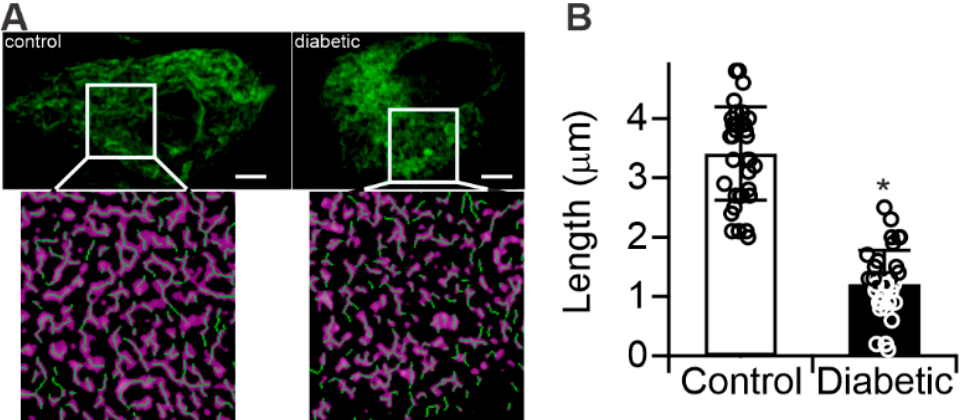
Figure 3. Structural analysis of human RPE mitochondria. ( A ) Mitochondrial morphology determined by MitoTracker Green staining of control- and diabetic-derived RPE. Inset = skeletonized (green lines) binary mask (purple) of deconvoluted photomicrographs highlighting mitochondrial morphology. Scale bars = 5 μ m; ( B ) Quantitation of average mitochondrial length. n = 3, * p < 0.05.